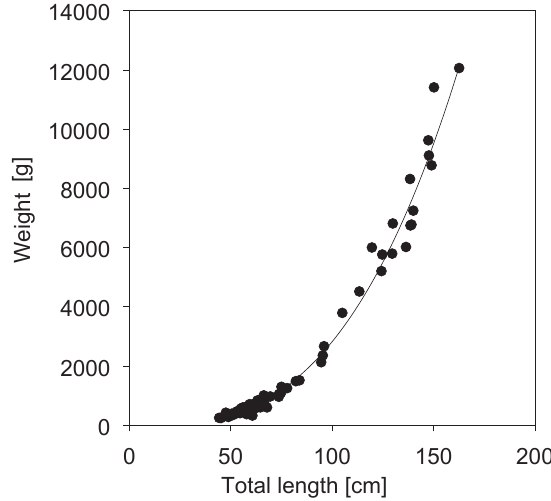
Fig. 9. Length–weight relations of Mustelus mustelus (based on all individuals) from the Gulf of Iskenderun, north-eastern Mediterranean Sea